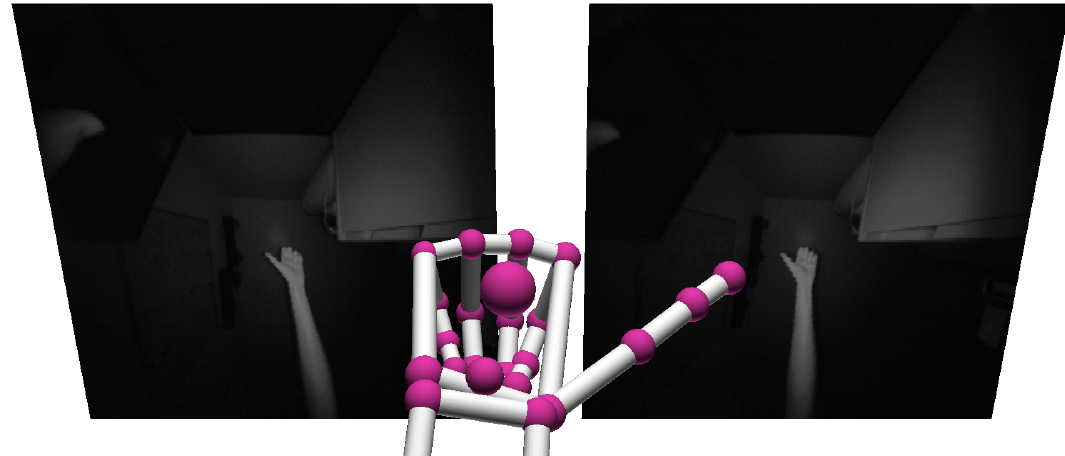
Figure 2. Screenshot of the view from Leap’s two infrared cameras and the detected hand